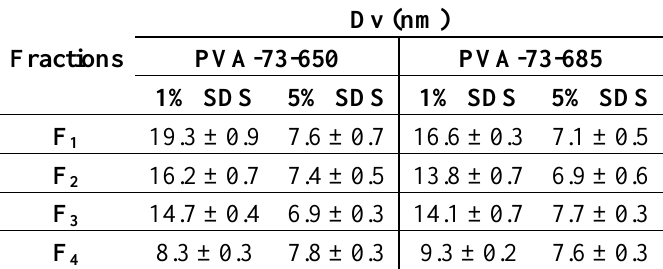
Table 4. The evolution of the size average (Dv) of different fractions of samples PVA-73-650 and PVA-73-685 at a SDS concentration of 1 and 5 wt% respectively with respect to